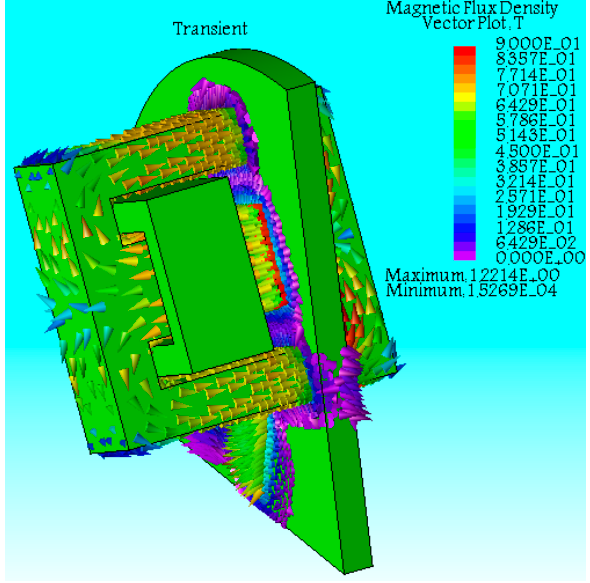
Figure 13. Lines of magnetic flux density in a pair of pole of the machine.